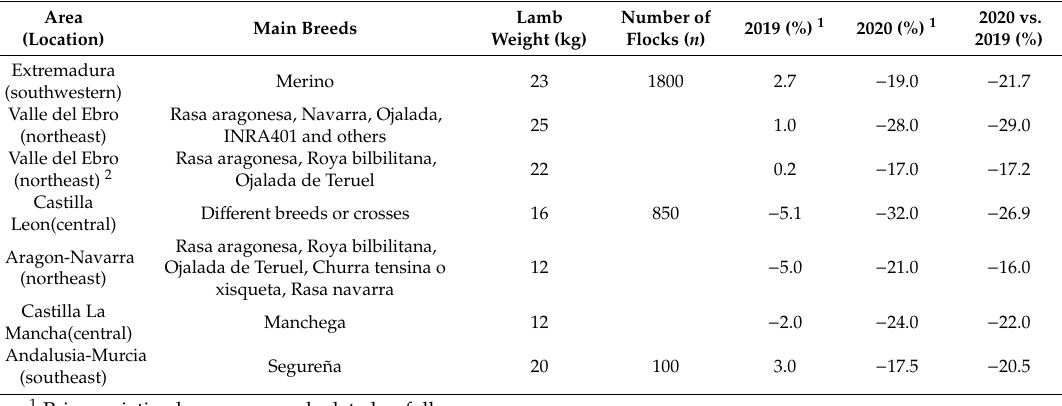
Table 2. Variation rate (%) of prices paid to producers in 2019 and 2020 per area (covering main breeds) and type of lamb (by weight at slaughter), as well as the number estimated of flocks